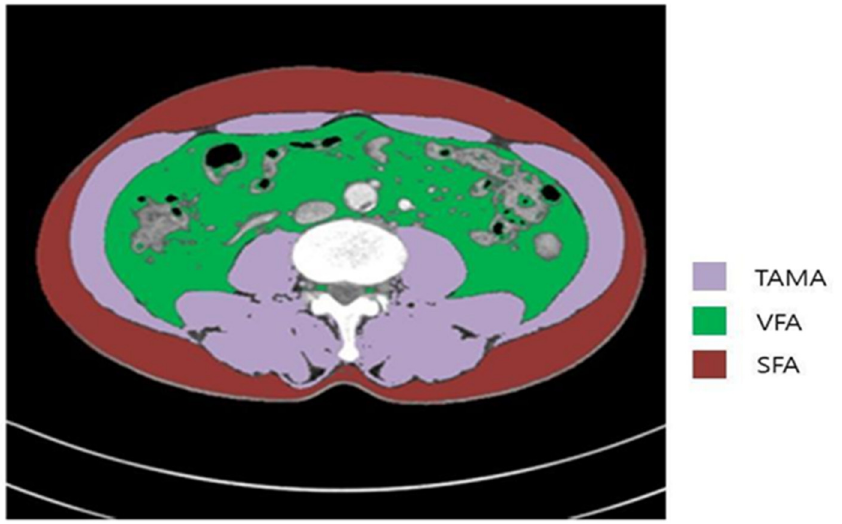
Figure 2. Body morphometric evaluations of abdominal fat and muscle areas. At the level of the inferior endplate of the L3 vertebra, an axial CT image was segmented into the total abdominal muscle area (TAMA), visceral fat area (VFA), and superficial fat area (SFA).